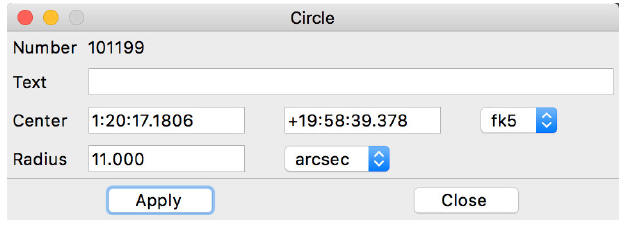
Fig. 45.— The extra window for our circular region